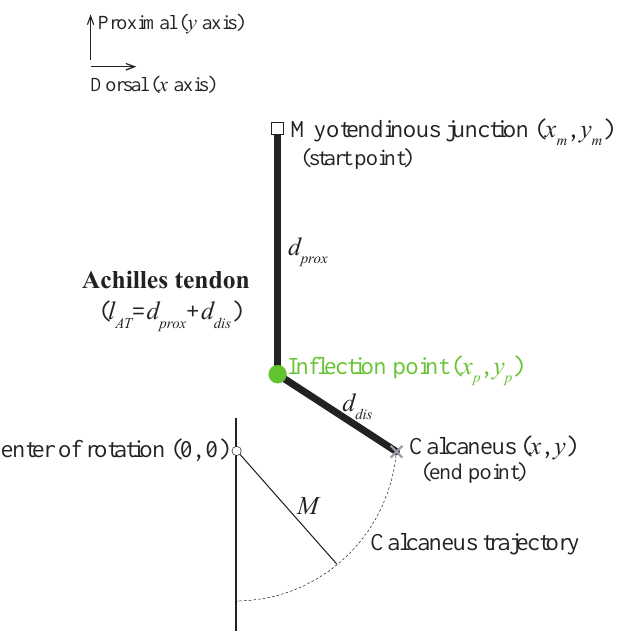
Center of rotation (0, 0)